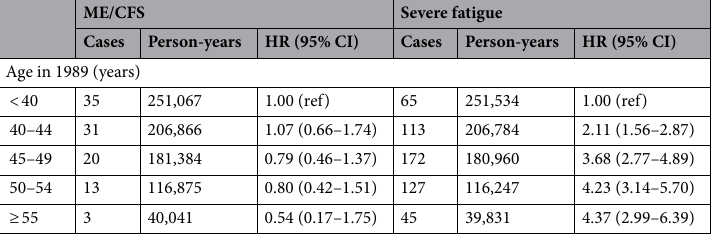
Table 2. Age in 1989 and risk of ME/CFS and Severe Fatigue. HR, hazard